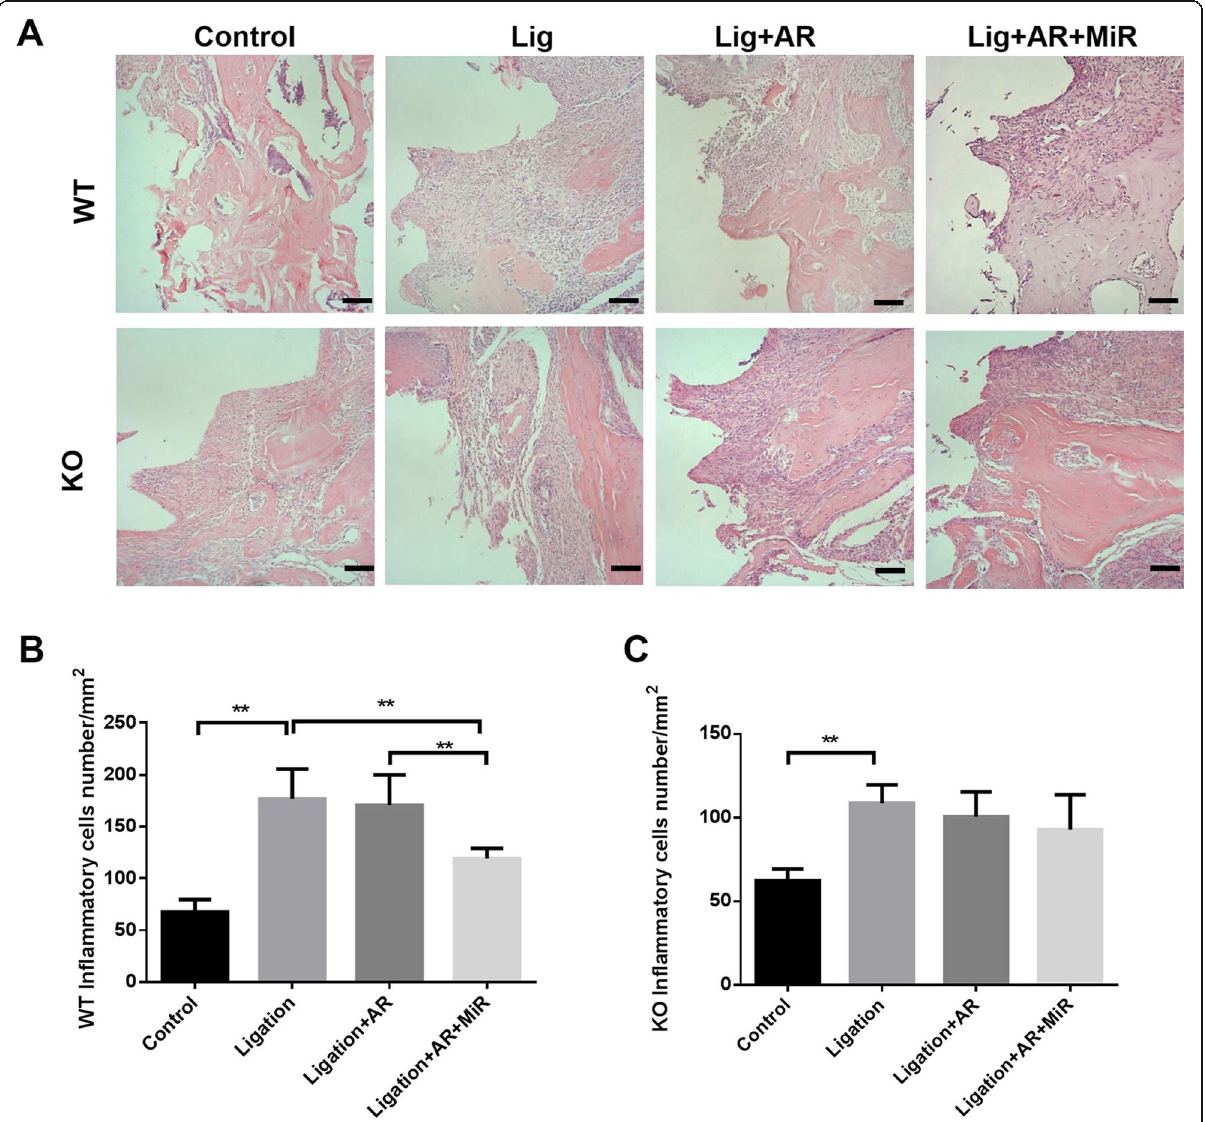
Fig. 4 Anti-RANKL and anti-RANKL+miR-146a treatments decreased the inflammatory cell infiltration of the implant gingival tissues with different patterns in experimental peri-implantitis of WT and TLR2/4 KO mice. HE staining of the gingival tissue around implants were performed in the control group, ligation group, ligation with anti-RANKL antibody treatment group, and ligation with anti-RANKL antibody + miR-146a treatment group in WT mice and TLR2/4 KO mice ( a ) (scale bar, 100 μ m). Inflammatory cell numbers were measured and analyzed in each group of WT mice ( b ) and TLR2/4 KO mice ( c ) (mean ± SD, n = 6, ** p <